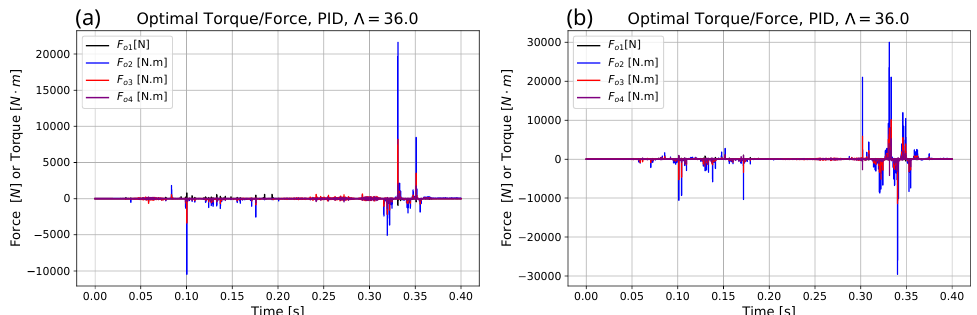
Figure 12. The adaptive control forces without force limitation and without the initial transient. ( a ) For set 1. ( b ) For set 2.